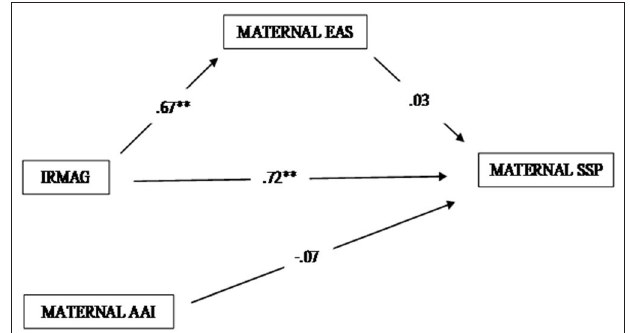
FIGURE 1 | Mediation model on children’s attachment toward mothers. **significant effect at 0.01 alpha level (two tails).